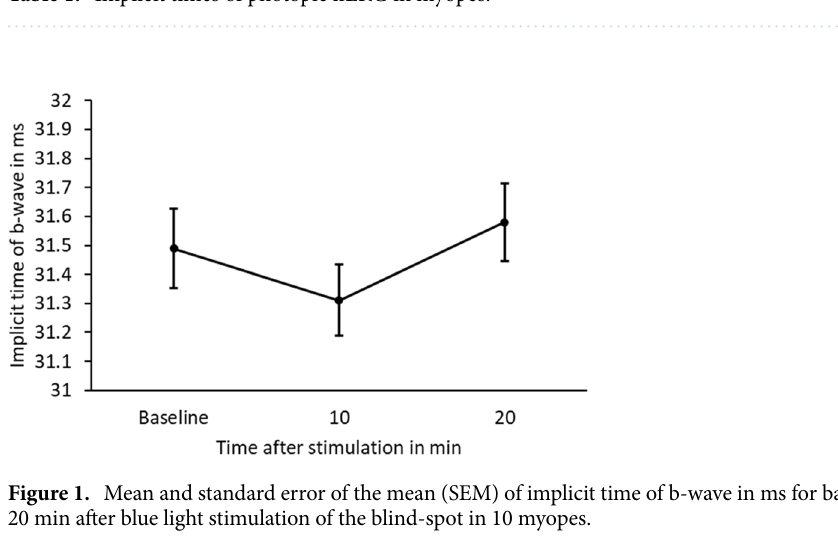
Table 1. Implicit times of photopic ffERG in myopes.